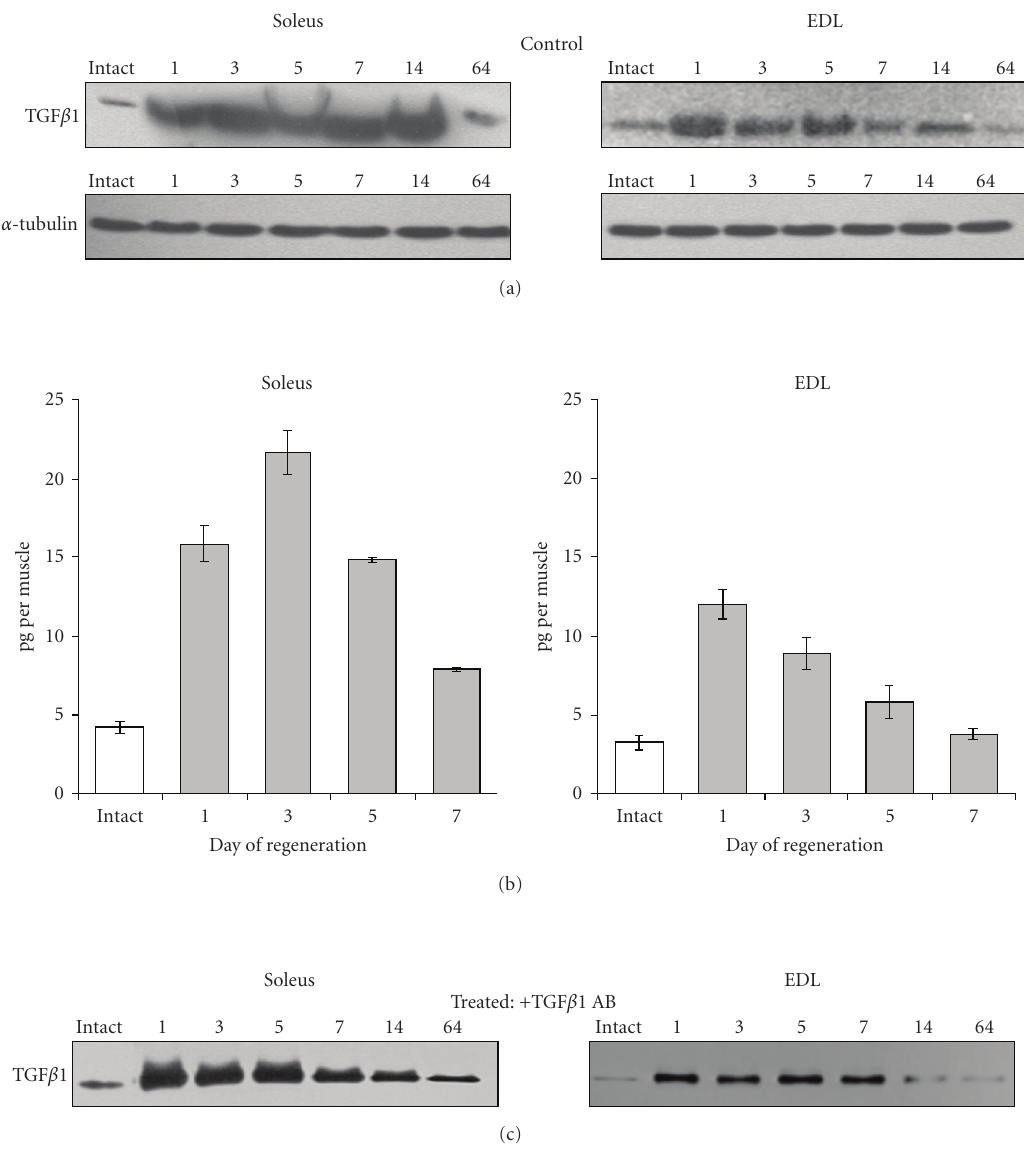
Figure 3: TGF β 1 protein levels during soleus and EDL muscle regeneration . (a) Representative immunoblots of TGF β 1 performed on extracts from control untreated soleus and EDL muscles taken at the indicated days after crush. Alphatubulin was used as control of loading. (b) TGF β 1 protein amount measured by ELISA during the first week after crush in untreated regenerating muscles (control). Levels of TGF β 1 are shown as pg per muscle fresh weight. In intact soleus and EDL muscles 4.19 pg per muscle and 3.24 pg per muscle were found, respectively. The data represent mean ± SE of 3 independent determinations each of them including 3 animals. All values found in regenerating muscles were statistically di ff erent from intact muscles ( P < . 05) except for EDL day 7. (c) Representative Immunoblots of TGF β 1 in extracts from muscles injected just after crush with anti-TGF β 1 antibody and taken at the indicated days after